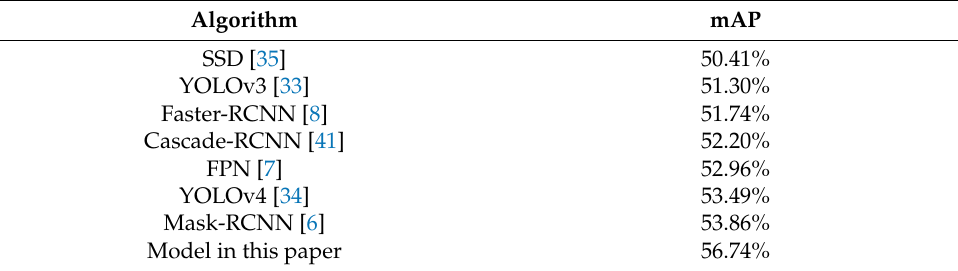
Figure 8. Loss change in unfreezing phase. Table 2. Different network detection result.